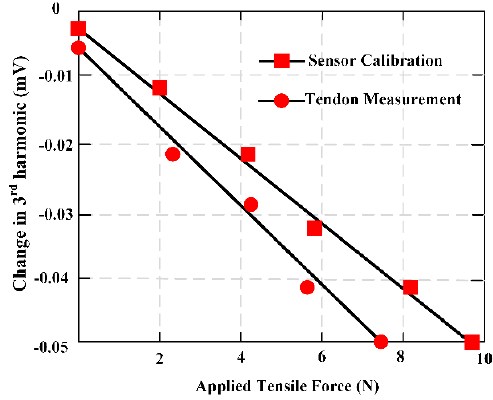
Figure 15. The force measurement through the magnetoelastic sensor (MES), the tendon was loaded from 0 to 10 N. MES calibration measurements are also shown in the red circles.